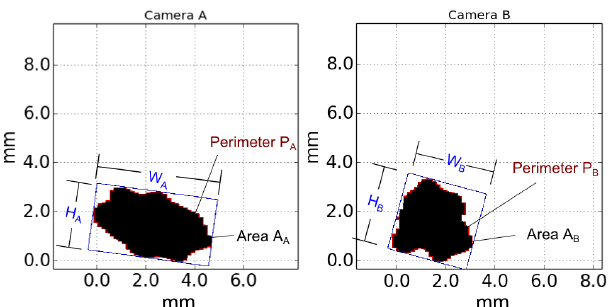
Figure 6. The definition of width ( W ), height ( H ), perimeter ( P ) and area ( A ) for a hydrometeor as recorded with the 2-DVD